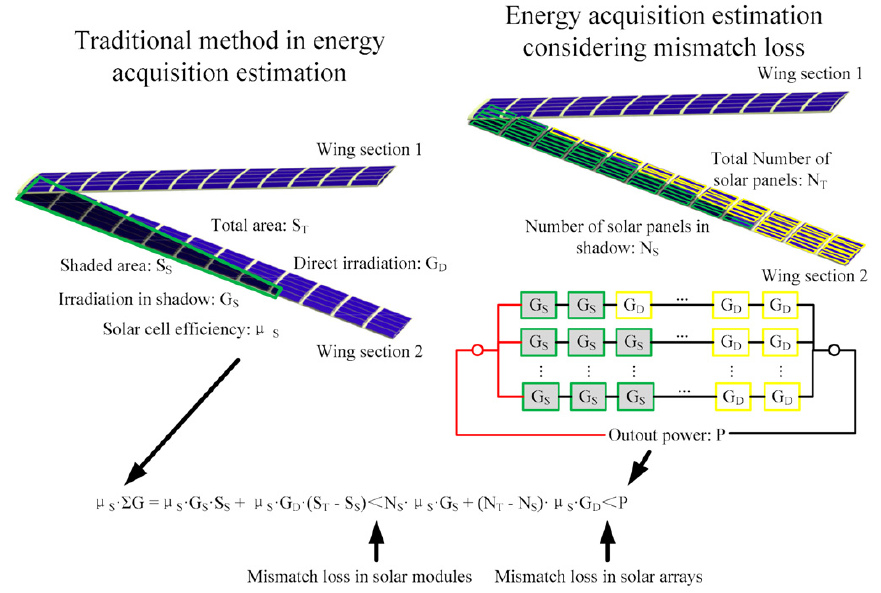
Figure 1. Energy acquisition estimation of solar-powered